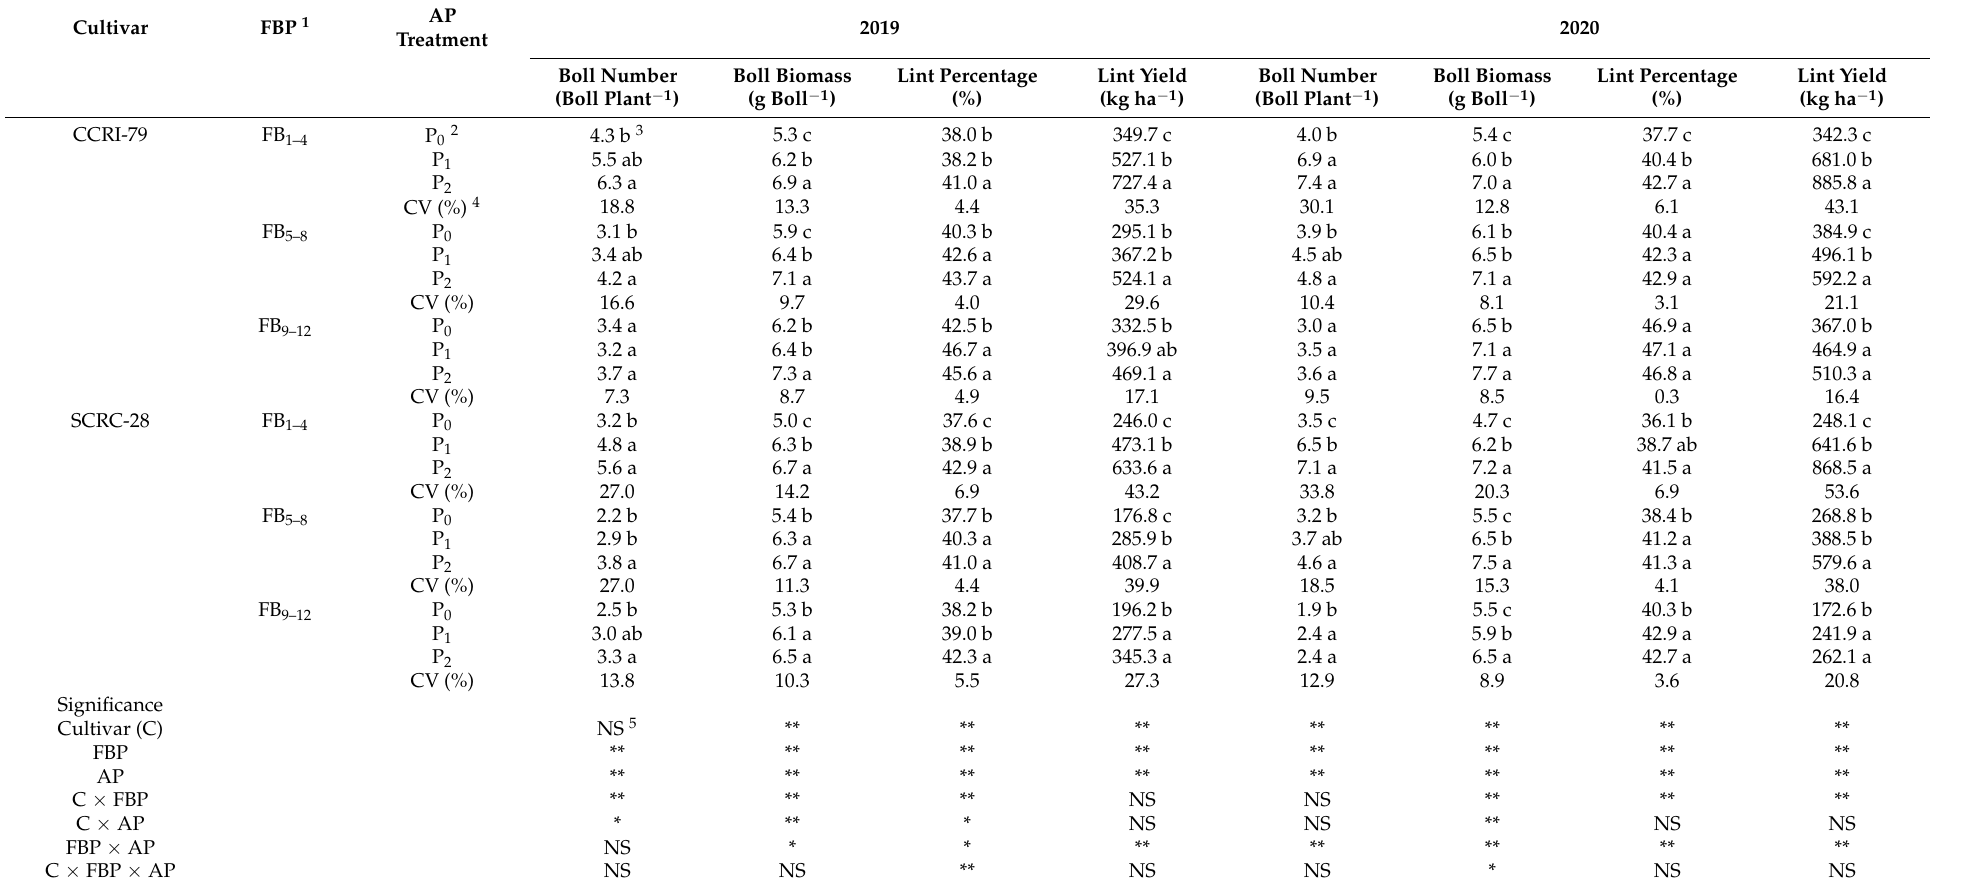
Table 5. The effect of soil available phosphorus (AP) on lint yield and yield components of different fruiting branches in 2019 and 2020.